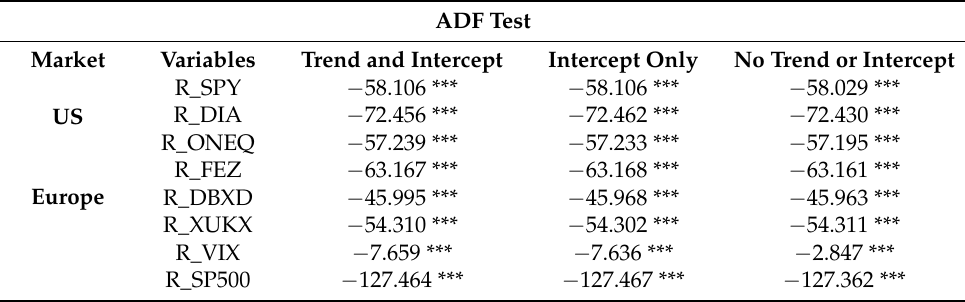
Table 3. Unit Root